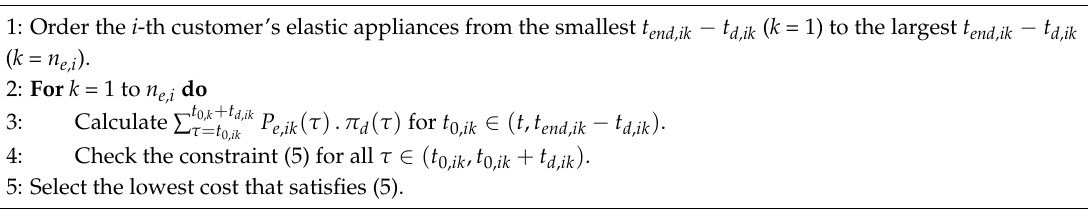
Algorithm 1. First Stage—Part 1: Schedule Elastic